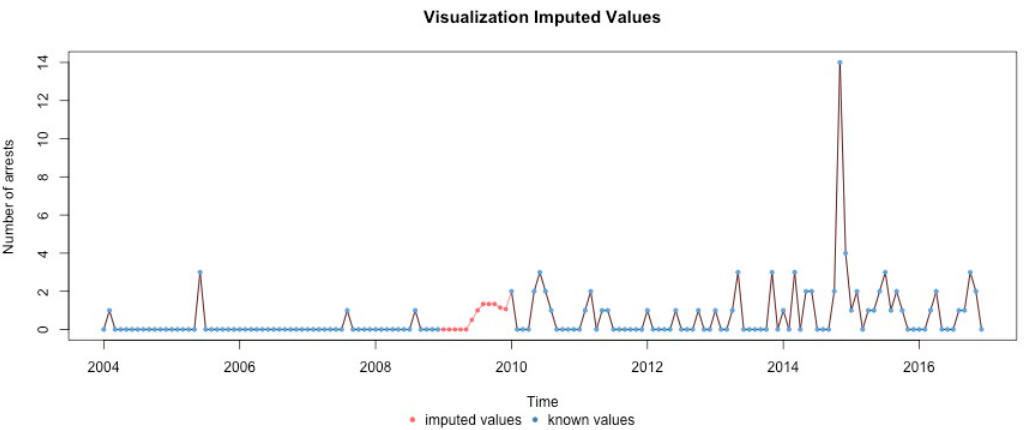
Figure A8. Precursor foreign nationals arrests 2004–2016 in the Czech Republic—imputed missing values.